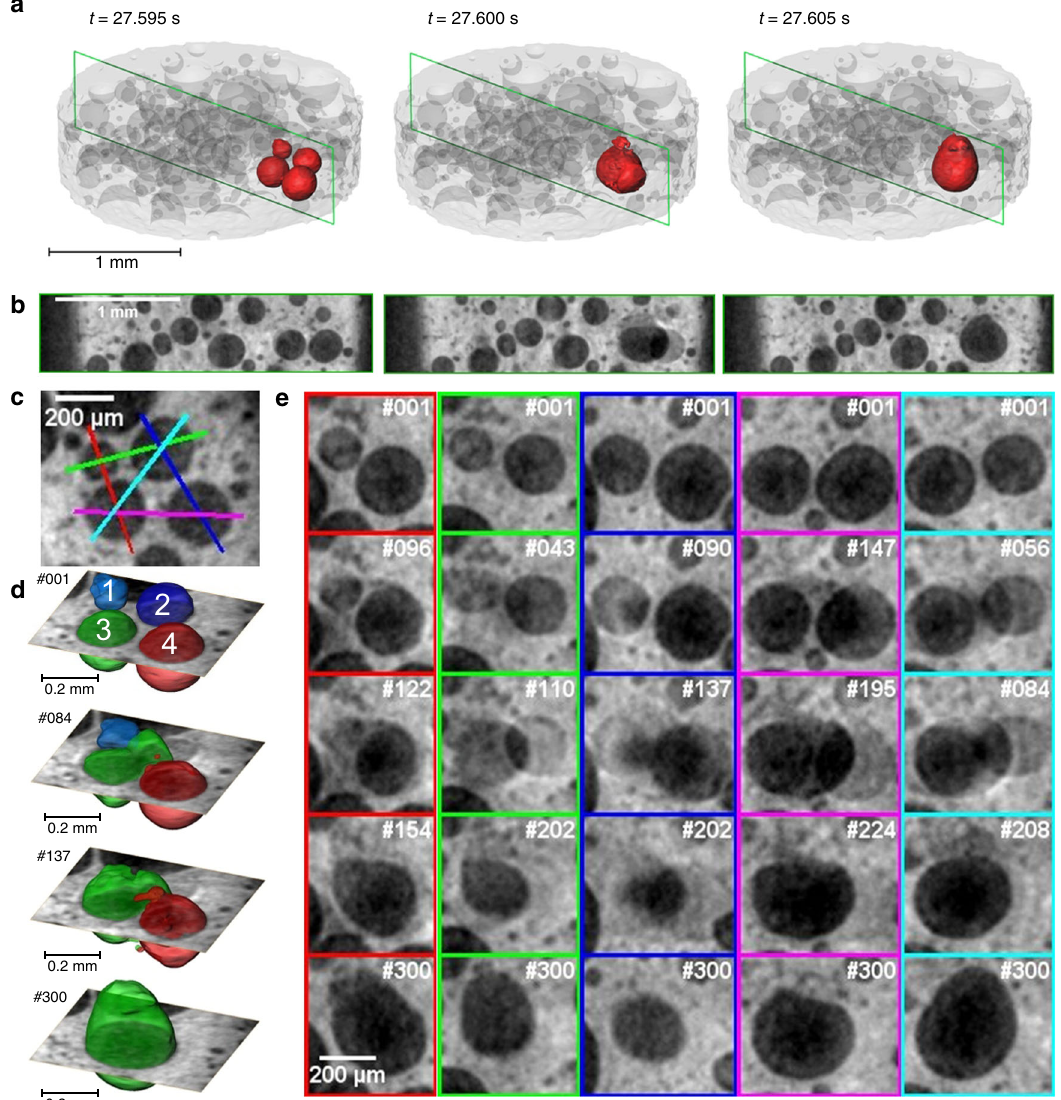
Fig. 6 Analysis of the coalescence of bubbles by tomoscopy at 208 tps (AlSi8Mg4 alloy). a 3D rendering of structure highlighting the bubbles under investigation. b Corresponding perpendicular slices of the structure. c De fi nition of fi ve colour-coded planes through the four bubbles in a . d , e Images/ slices obtained by the incremental reconstruction technique described in Supplementary Fig. 2. Numbers #nnn refer to time increments of 25 µ s starting from an arbitrary point. d 3D rendering at various times showing the original con fi guration of numbered bubbles (#001). The con fi guration changes after 2.08 ms in #084 where bubble 2 and 3 have merged to a dumbbell-shaped intermediary bubble. In #137, (3.83 ms from the beginning) bubble 1 has completely merged into the dumbbell-shaped one. Even later, after 5.6 ms (#300) bubble 4 has also joined. e Slices in the planes de fi ned in c showing the merger of bubbles in d in more